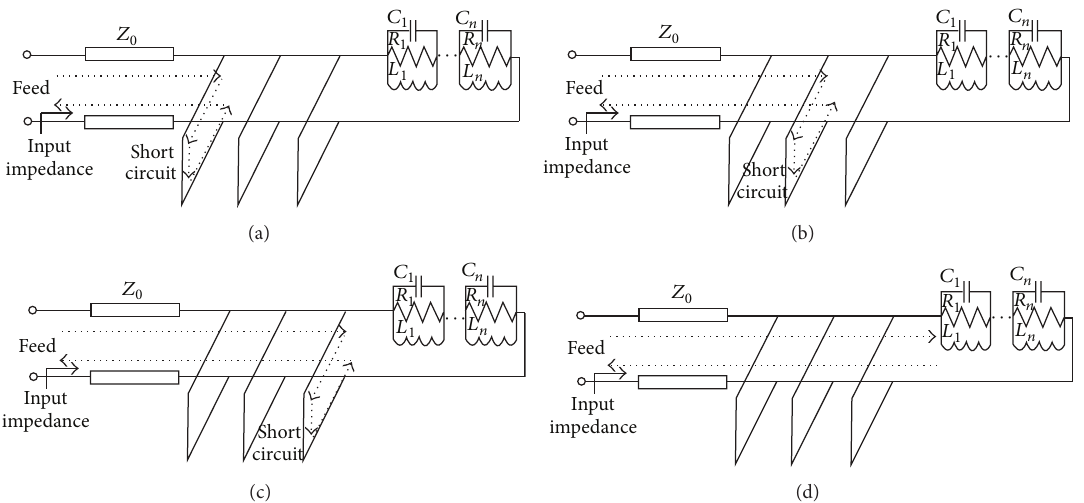
Figure 10: Equivalent circuit models of the proposed antenna. (a) The first notched band, (b) the second notched band, (c) the third notched band, and (d) the unnotched